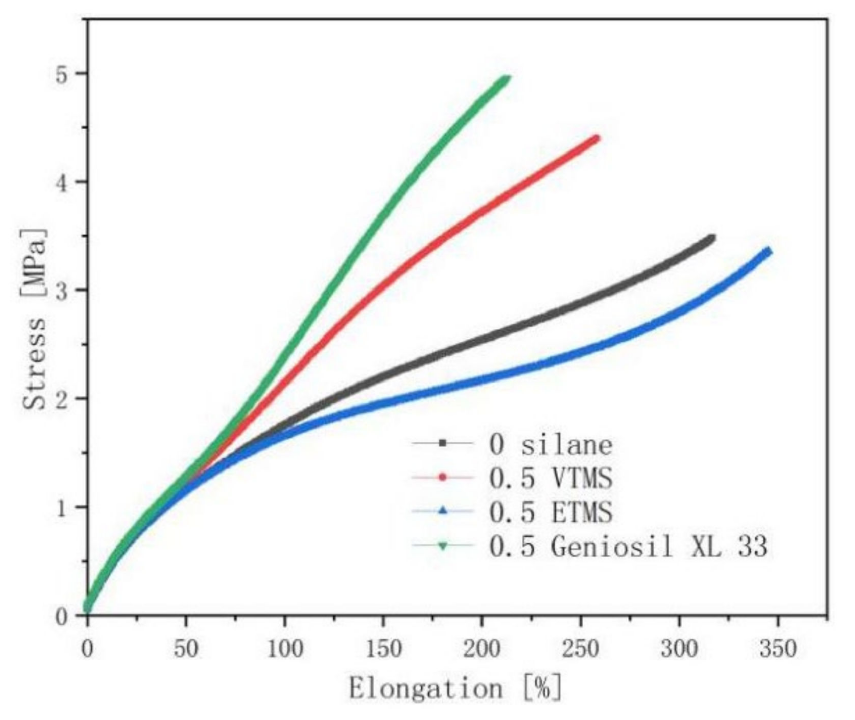
Figure 3. Stress–strain curves of the EPDM/CaCO 3 composites.